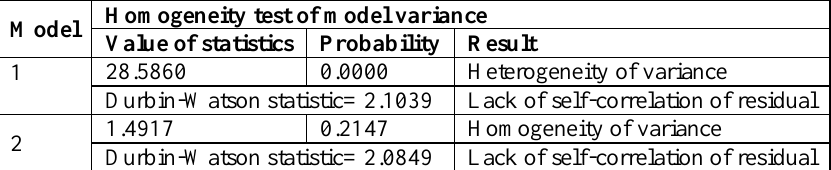
Table 4: Homogeneity of variance and non-self-correlation test